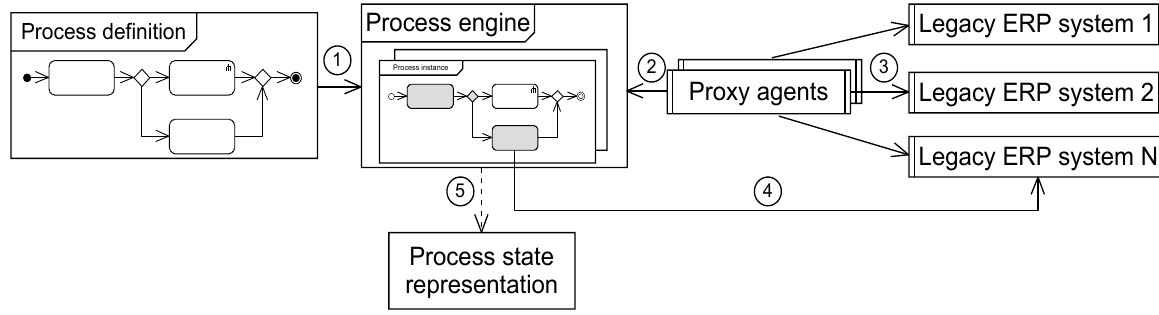
Figure 7. Conceptual architecture for process engine integration with multiple legacy ERP systems in the CBP